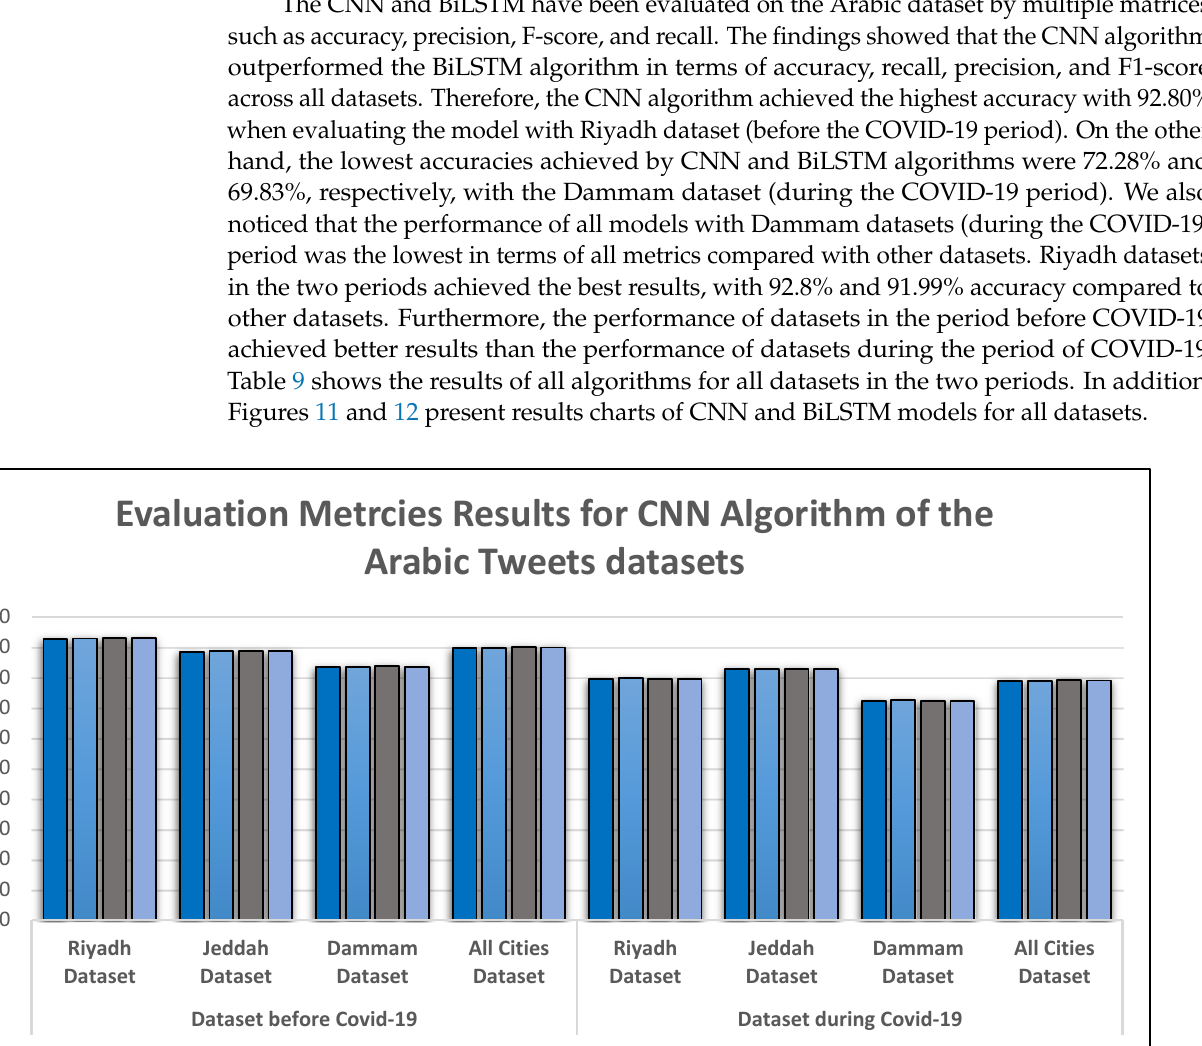
Table 9. The performance metrics of CNN and BiLSTM algorithms on datasets in all two periods.